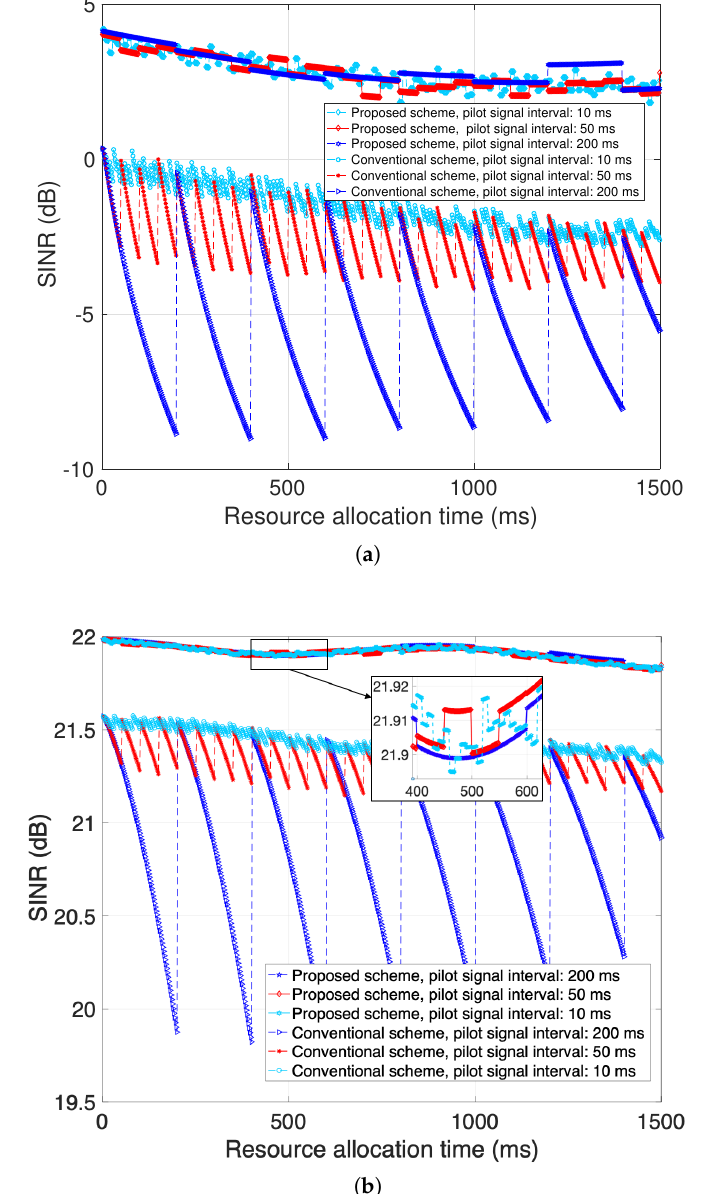
Figure 7. Beamforming performance for varying pilot signal transmission intervals. ( a ) LCMV beamformer. ( b ) DL